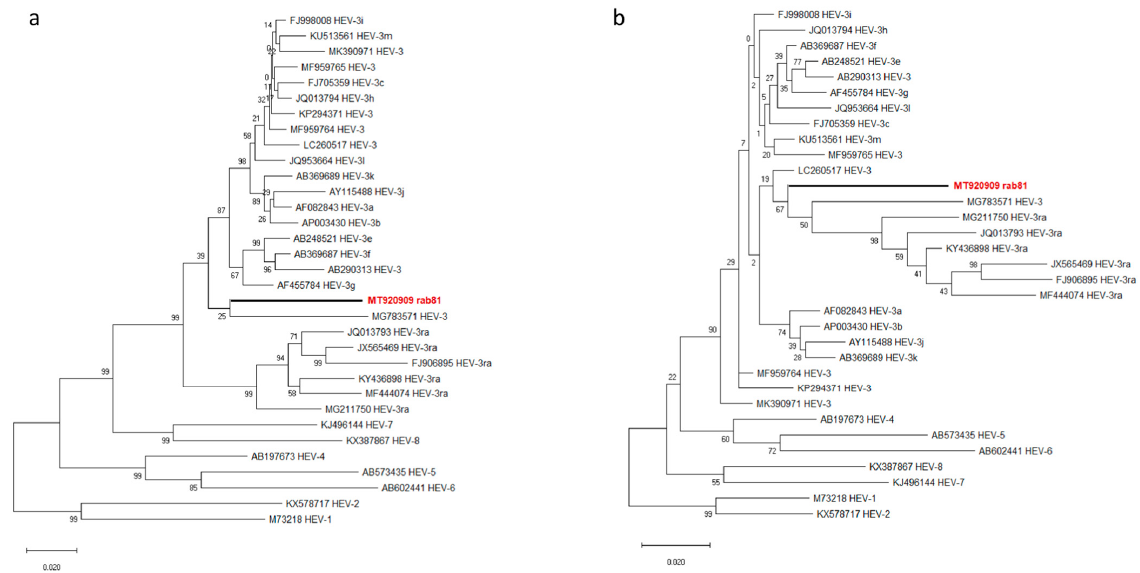
Figure 3. Phylogenetic trees based on amino acid sequences of ORF1-encoded polyprotein ORF1 ( a ) and ORF2-encoded capsid protein ( b ) of HEV. Red boldface indicates the novel rabbit HEV strain. The phylogenies were reconstructed using maximum-likelihood and the Jones–Thornton–Taylor matrix-based model with node support values given from 500 bootstrap replicates.